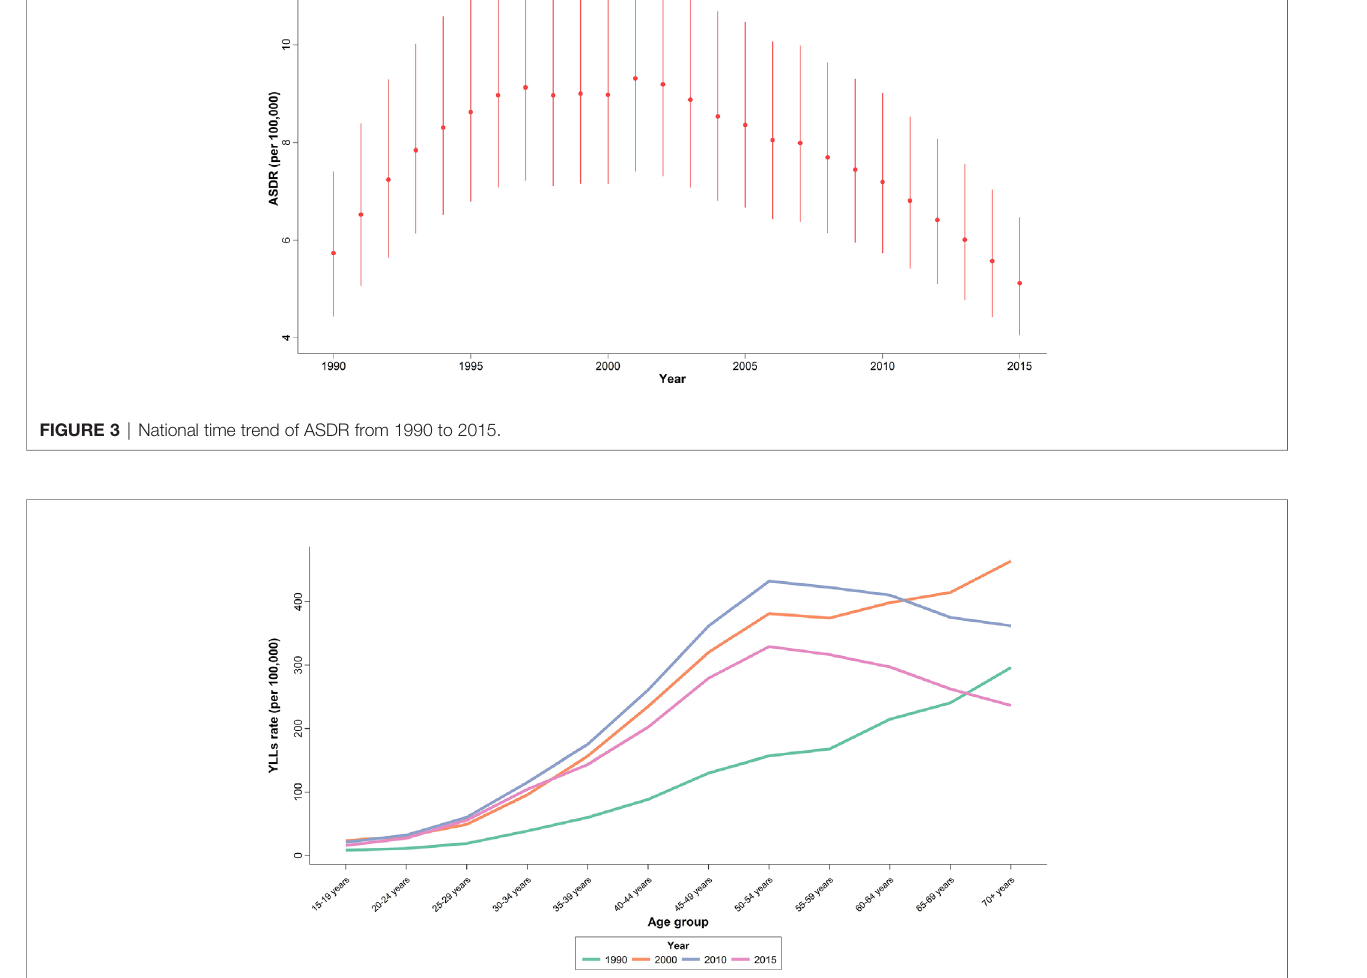
pattern of ASIR in the majority of provinces, the difference between the provinces with the highest and lowest ASIRs signi fi cantly increased by about twofold during the study period ( Figure S2 ). Decomposition analysis of the majority of provinces